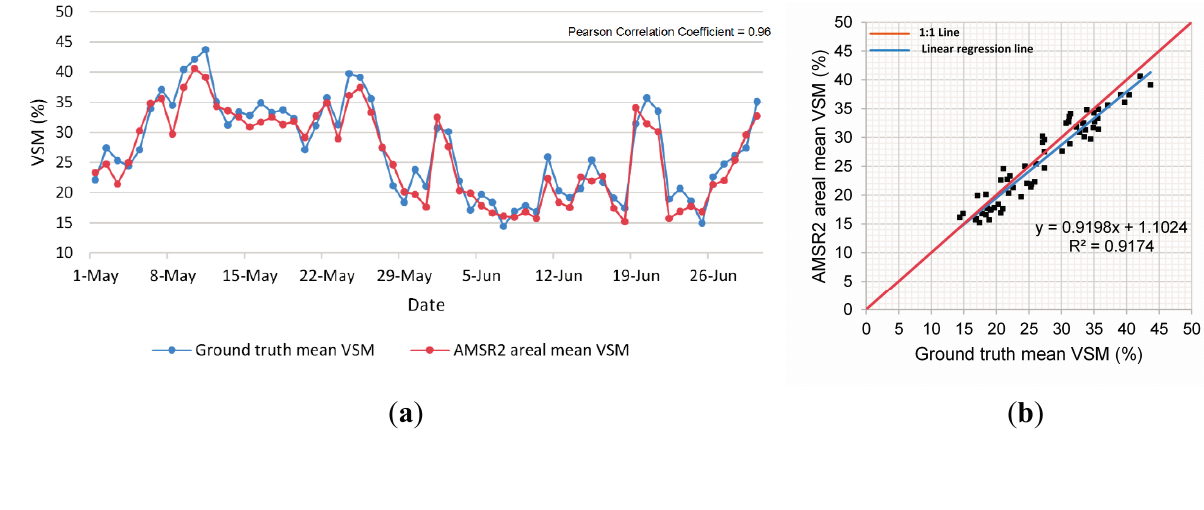
Figure 13. ( a ) The correlation analysis of mean VSM of ground truth and AMSR2. ( b ) The regression line and 1:1 line based on mean VSM of ground truth and